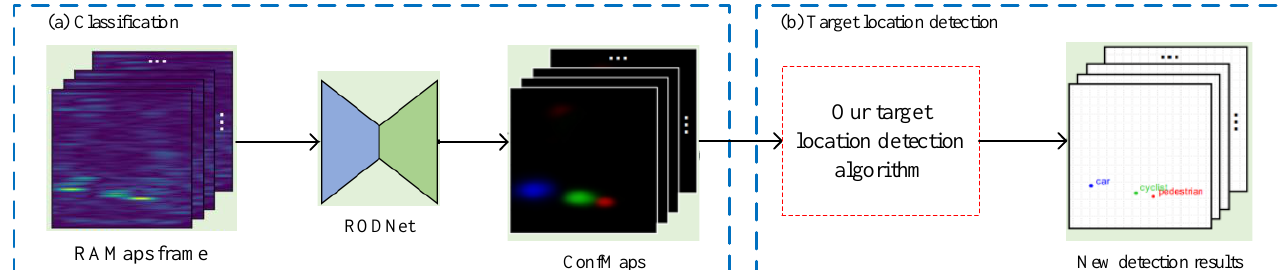
Figure 12. A flow chart of improved RODNet algorithm proposed in this paper.